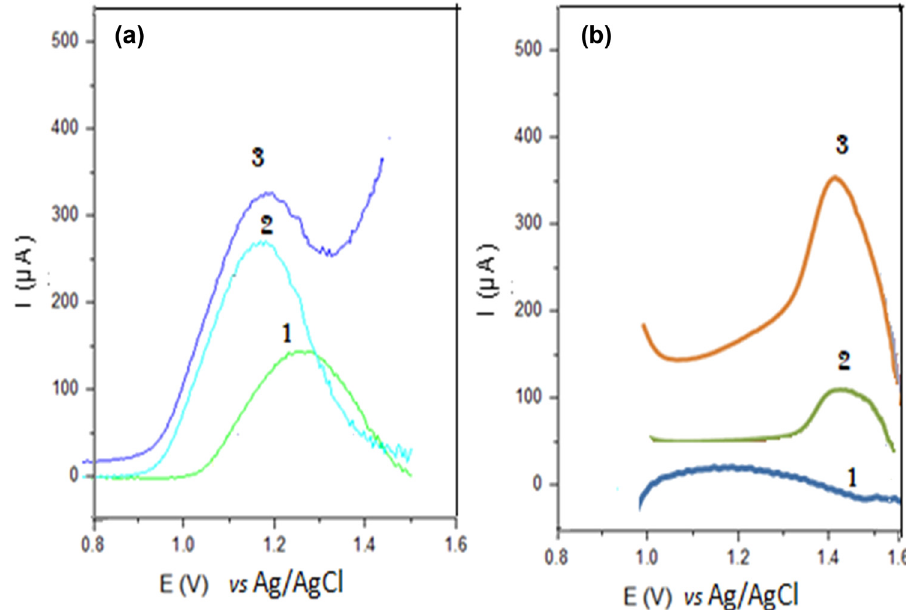
Figure 5: Square wave voltammograms obtained using CPE - I electrode for ( a ) of 3.3mmolL − 1 of PROP in ( 1 ) acetate bu ff er ( pH 4 ) , ( 2 ) in 0.1molL − 1 of H 2 SO 4 ( pH 2 ) , and ( 3 ) in phosphate bu ff er solution ( pH 7 ) , and ( b ) for 3.3µmolL − 1 of ATN in ( 1 ) NaNO 3 ( pH 4 ) , ( 2 ) in phosphate bu ff er solution ( pH 7 ) , and ( 3 ) in 0.1molL − 1 of H ( pH 2 ) , at scan rate of 100mVs − 1 and pulse amplitude of 30mV. 2 SO 4